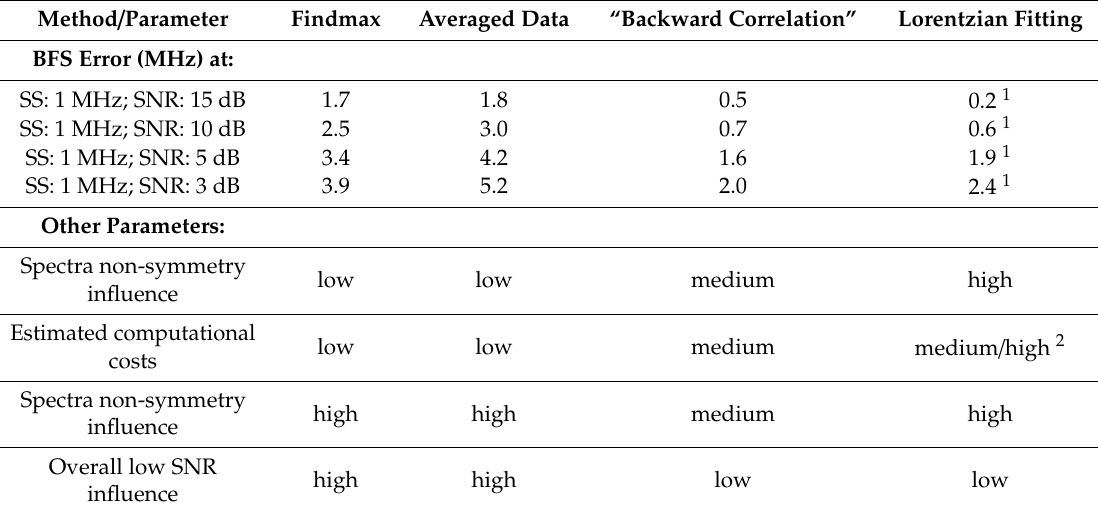
Table 2. A comparison of all discussed methods obtained from data simulated with the 1 MHz scanning step (SS). Method / Parameter Findmax Averaged